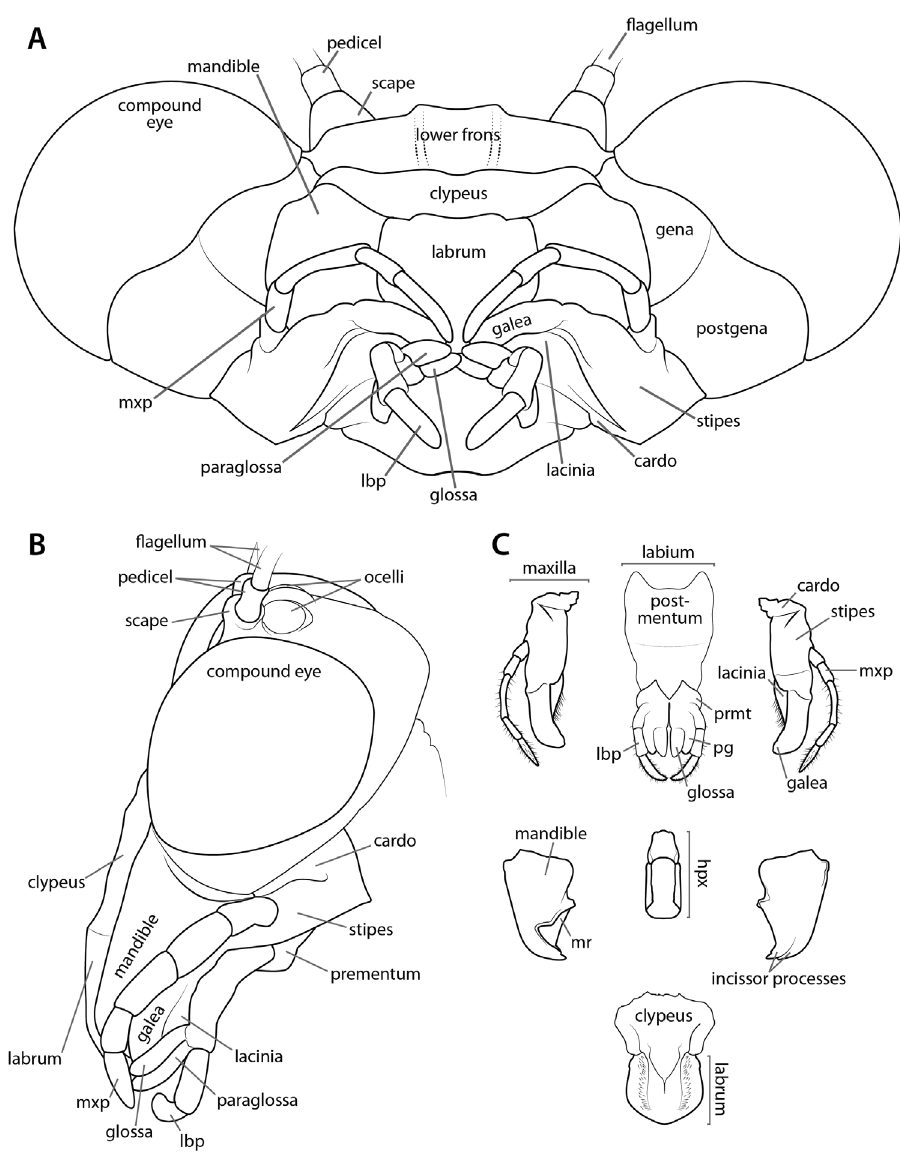
Figure 3. Annotated illustrations of cranial structures. Omomantis sp. ♂ cranium A anteroventral view; B lateral view. Tenodera sinensis Saussure, 1871 C disarticulated components of mouthparts. Illustrations by Josh Maxwell. Abbreviations: hpx = hypopharynx; lbp = labial palp; mr = molar ridge; mxp = maxillary palp; pg = paraglossa; prmt =